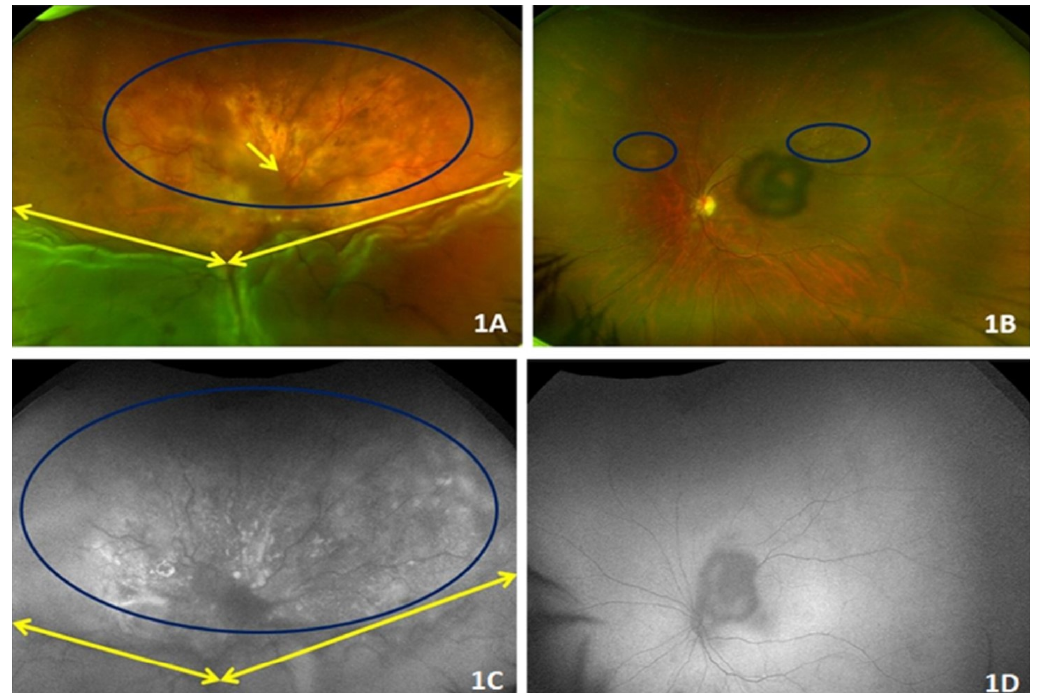
Figure 1: A) Right-eye color fundus photo showed a hazy optic disc, minimal tortuosity of veins, exudative retinal detachment from 3 to 9 clock hours (yellow double-headed arrows), a small pocket of subretinal fluid superior to the optic disc (yellow arrow), and discrete yellowish choroidal lesions with ill-defined margins in the superior quadrant of fundus (blue ellipse). B) Left-eye color fundus showed normal optic disc and vasculature with discrete yellowish choroidal lesions along the superior arcade and superonasal to the optic disc (two blue ellipses), with a central black shadow artifact due to cataract. C) Right-eye fundus autofluorescence showed a mottled hyper- and hypo-autofluorescent pattern in the superior quadrant. D) Left-eye fundus autofluorescence was normal with cataract shadow artifact at the center.